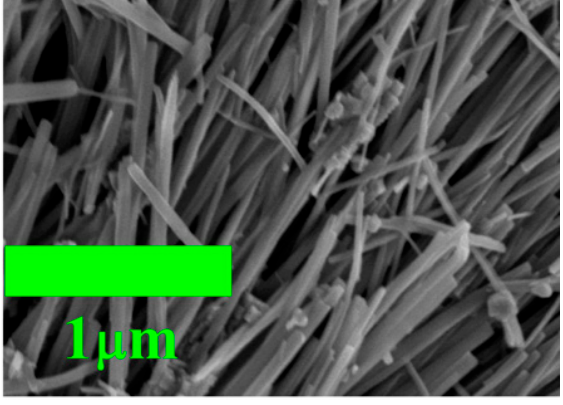
Figure 2. The scanning electron microscope image of BaTiO 3 nanofibers .